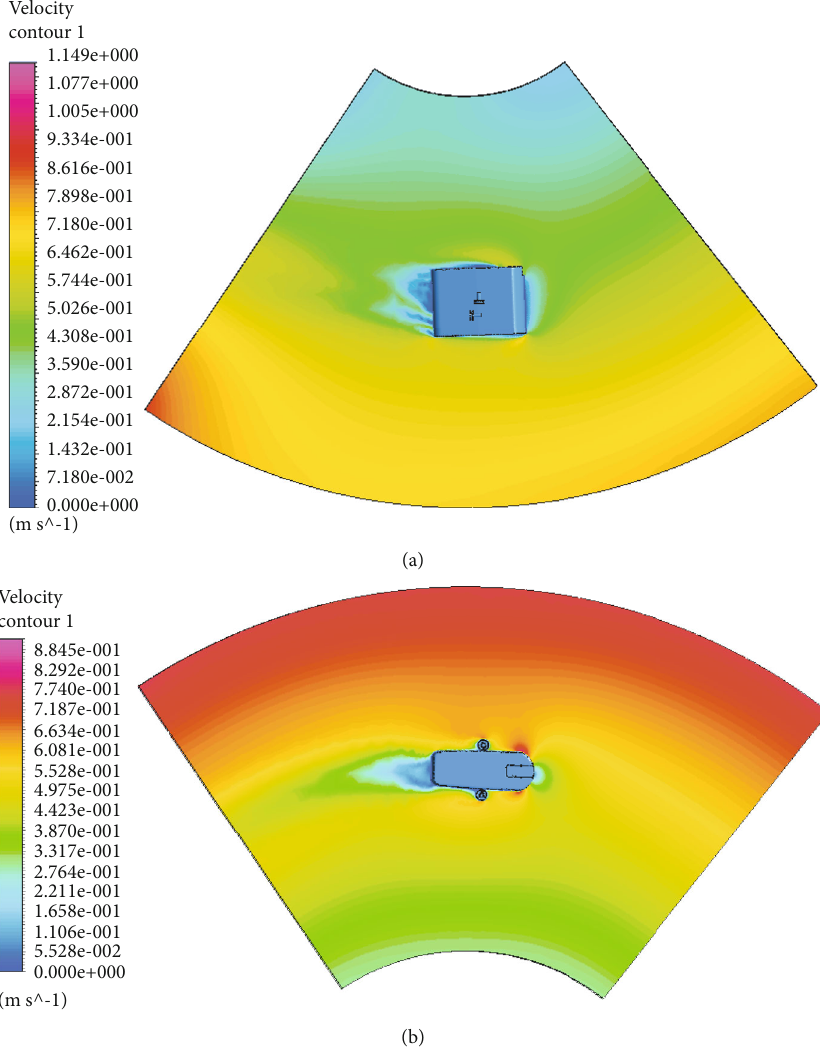
Figure 7: Velocity contour: (a) vertical plane; (b) horizontal plane. Table 3: Calculation statistics